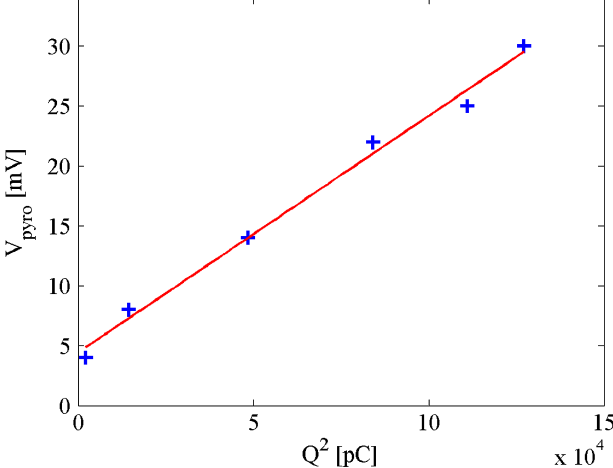
FIG. 23. Variation of the pyro-detector signal with the square of the bunch